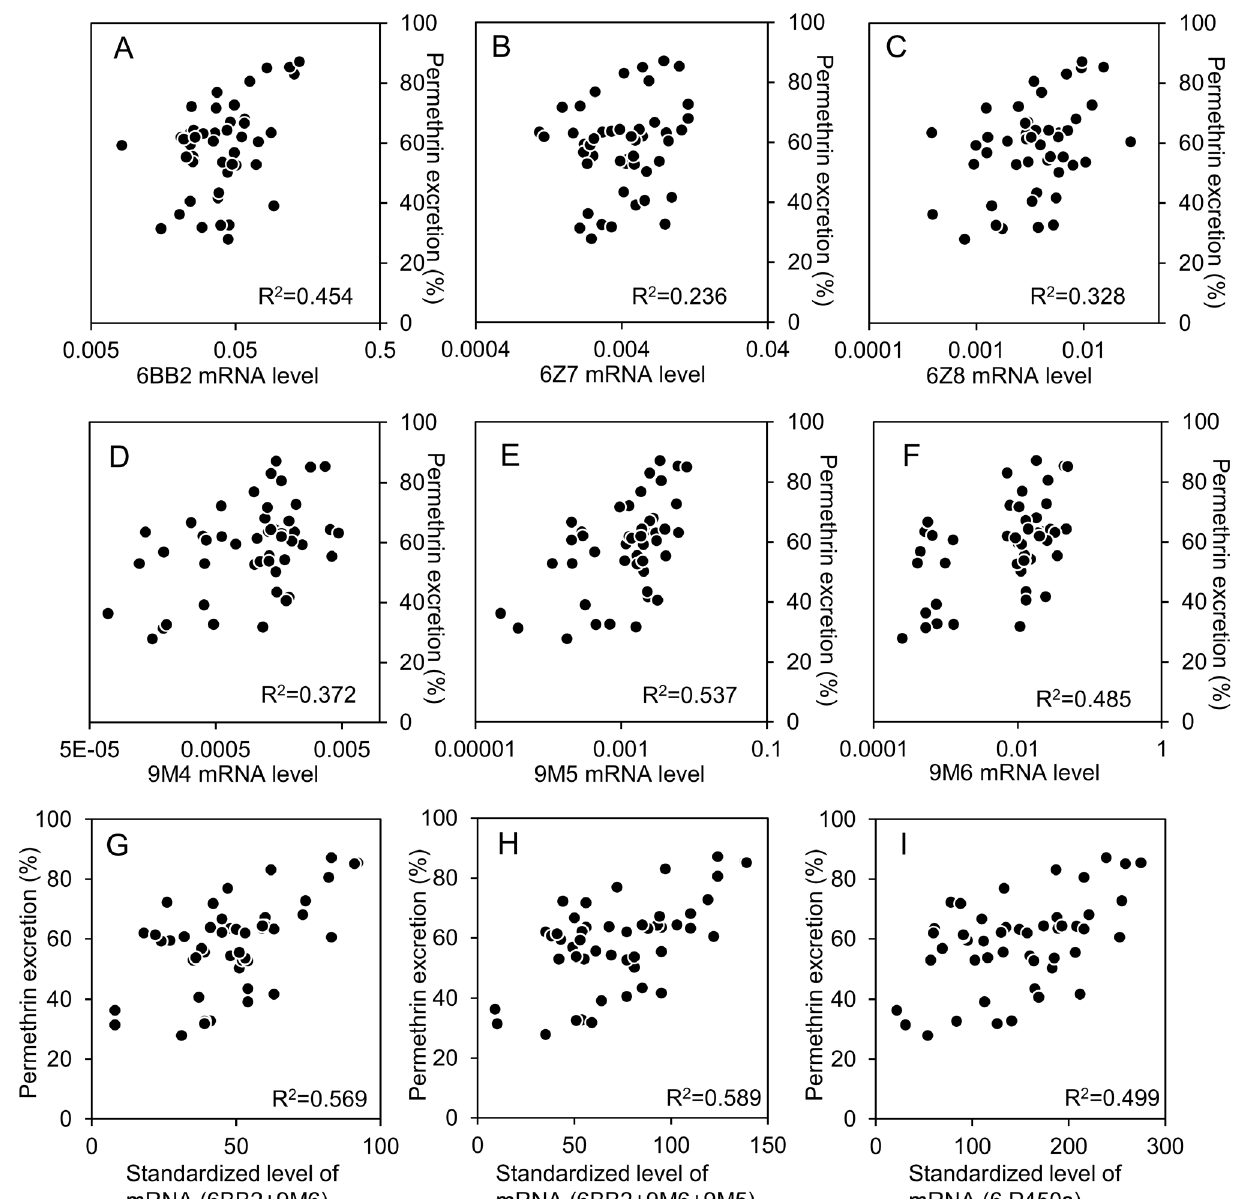
Figure 7. Associations between the gene expression level of six P450s and permethrin excretion rate. The female F2 populations of SP and SMK strains were dosed with [ 14 C]-permethrin and the amount of permethrin excreted by each insect was quantified 24 h after treatment. The level of mRNA was quantified using RNA isolated from each mosquito. For more information, see Materials and Methods. (A) CYP6BB2 , (B) CYP6Z7 , (C) CYP6Z8 , (D) CYP9M4 , (E) CYP9M5 , and (F) CYP9M6 . Forty-eight individuals were ranked from 1 to 48 according to the level of expression of each P450 gene. The ranks against multiple P450 genes were combined to standardize the level of mRNA and evaluate the association between permethrin excretion rate and expression level of multiple P450 genes. (G) Association between permethrin excretion and standardized level of mRNA for CYP6BB2 and CYP9M6. (H) Association between permethrin excretion rate and standardized level of mRNA for CYP6BB2, CYP9M6 and CYP9M5. (I) Association between permethrin excretion rate and standardized level of mRNA for CYP6BB2, CYP6Z7, CYP6Z8, CYP9M4, CYP9M5, and CYP9M6.